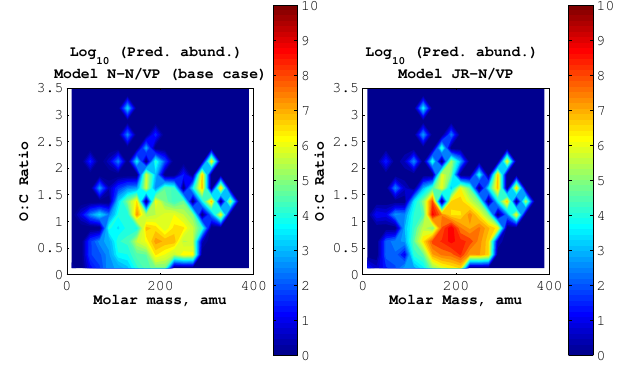
Fig. 5. Predicted binned organic component condensed moles plot- ted as a function of molar mass and O:C ratio for the 2742 MCM compounds with concentrations taken from the standard scenario (1.0/1.0/1.0 NO x -SF/AVOC-SF/BVOC-SF) with T = 293 . 15K, %RH = 70 and 3.0µgm − 3 involatile core. The colour axis is the base 10 logarithm of the cumulative concentration of the condensed components (in moleculescm − 3 ) in the respective bin. The bins are defined by a subdivision of the O:C scale into bin width of 0.25, and the MW scale into bin widths of 20gmole − 1 . The left hand panel shows the distribution for the predicted composition generated us- ing the N-N/VP (base case) model while the right hand panel shows a similar plot for the JR-N/VP model ( γ i = 1 for both